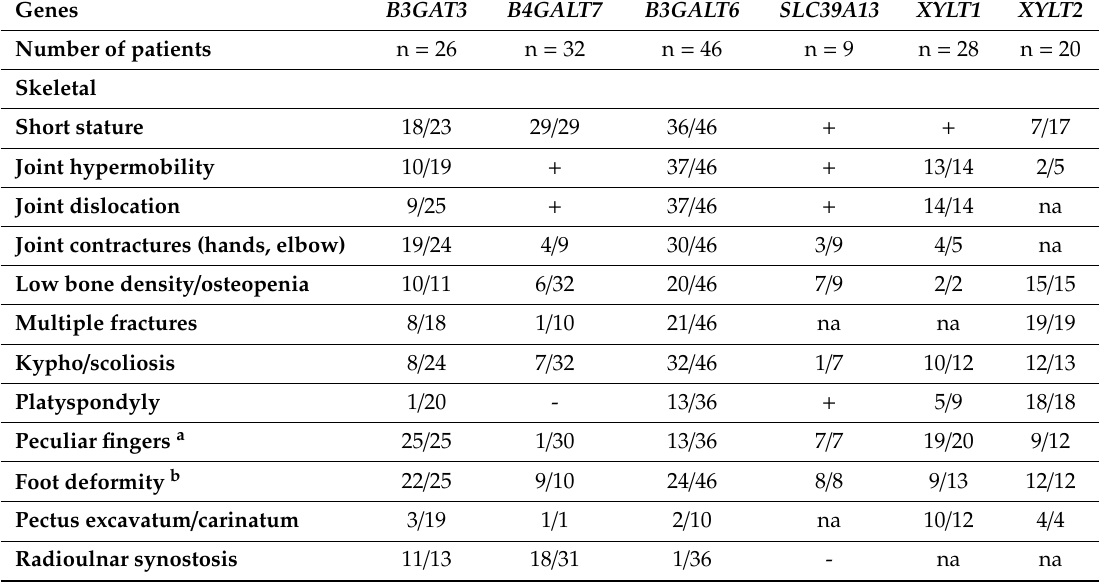
Table 3. Clinical features of